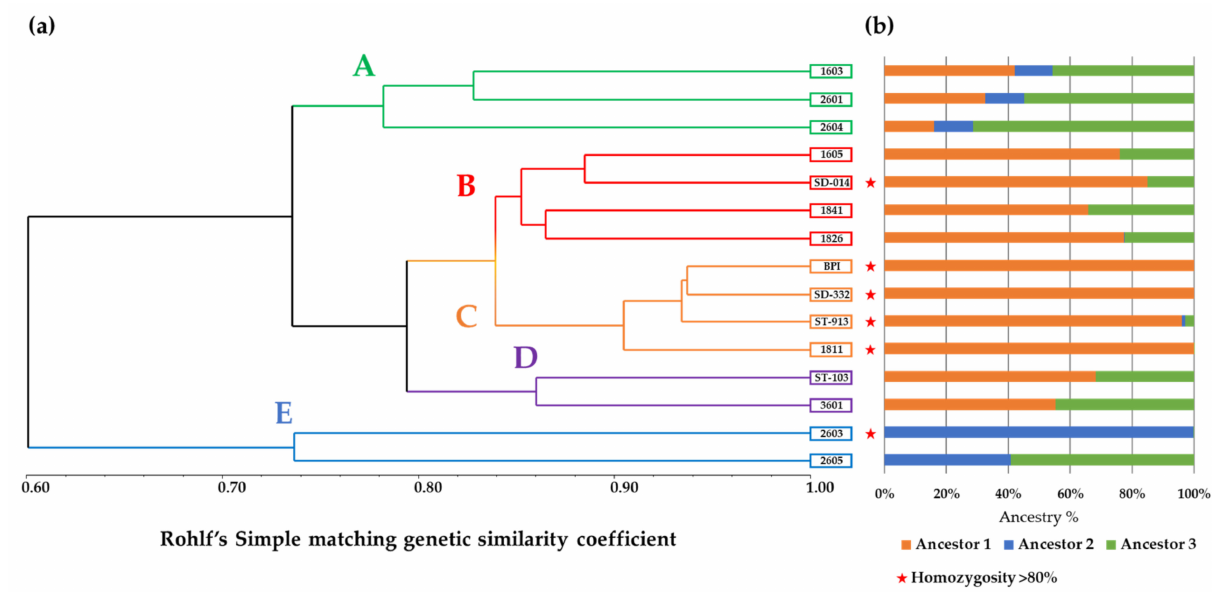
Figure 1. ( a ) UPGMA dendrogram based on the pair-wise genetic similarity matrix highlighting five main “Clusters” for the no missing values containing dataset. ( b ) STRUCTURE software histogram for K = 3 of 15 individuals of Lavandula with a no missing values containing dataset (“red star” symbol labels individuals with homozygosity